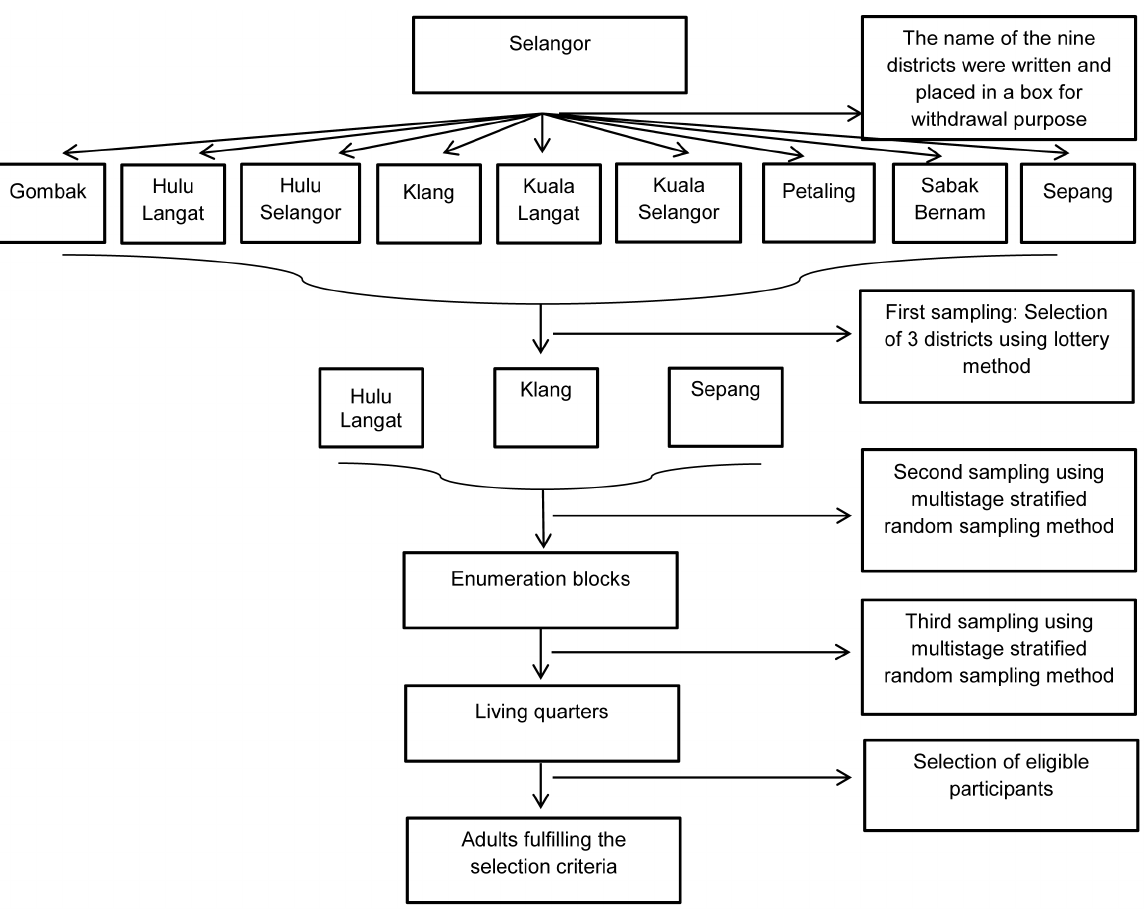
Figure 2. Flow chart of sampling method. The above figure shows the sampling method of this research. The sampling frame for this study was obtained from the Department of Statistics (DOS), Malaysia. A multistage stratified random sampling method was used for the selection of enumeration blocks and living quarters in each of the three districts in Selangor.